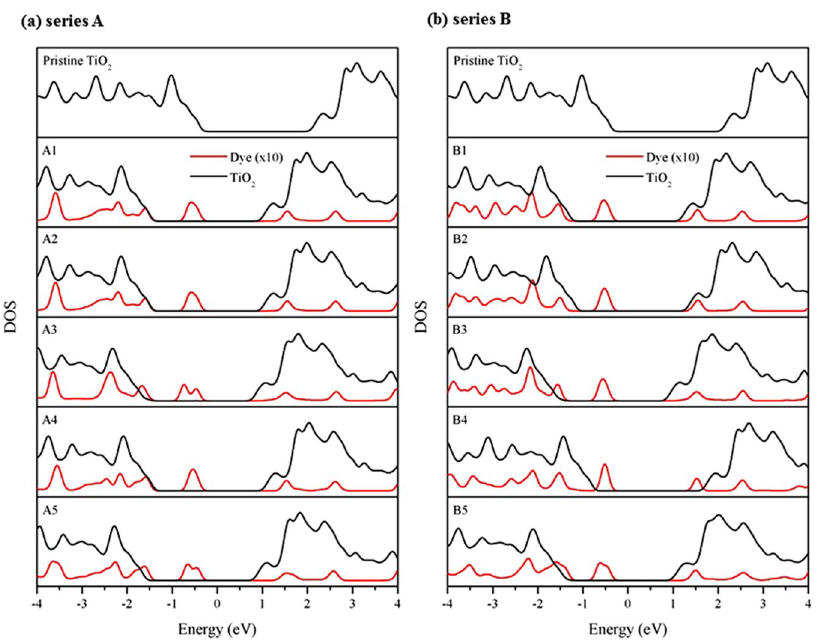
Figure 5. The projected density of states of TiO 2 and dyes of five stable configurations of both A and B dyes. (The black lines represent DOS of the TiO 2 whereas the red lines denote either TP-COOH or TP- CN COOH in dye molecule with enlarged 10 times of y-axis.)